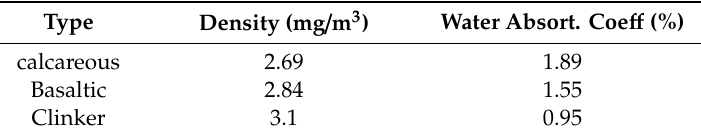
Table 2. Aggregates characterization.